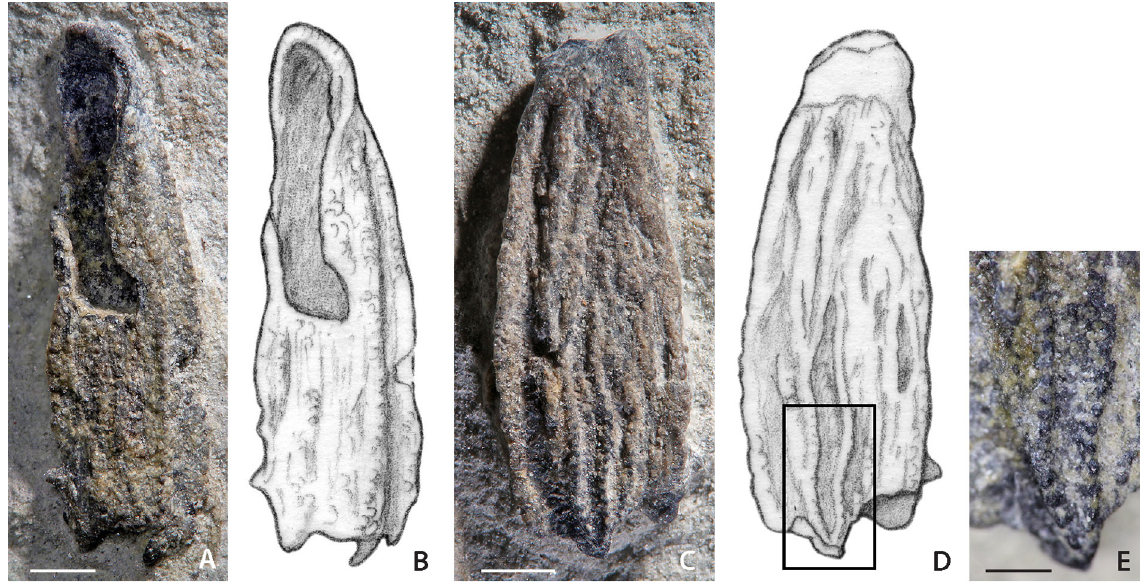
Fig. 10. Microbrachius kedoae from the Gavrilchitsy 45 borehole . Proximal part of the pectoral arm. A , B , GIT 767-19. C – E , GIT 767-20. A–D, scale bars = 1 mm, E, scale bar = 0.5